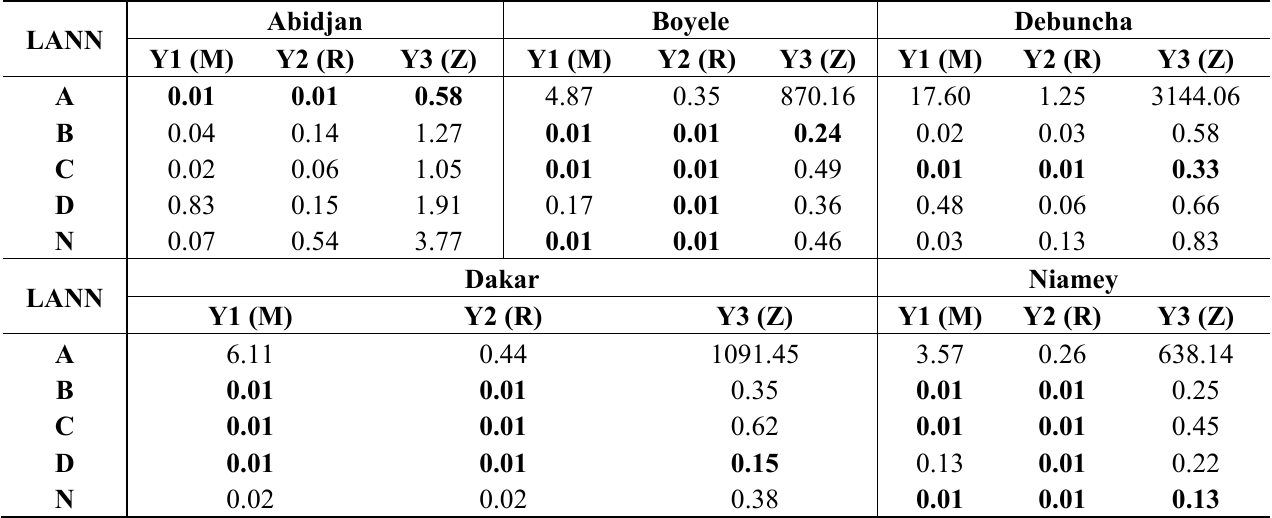
Table 4. Comparisons between RMSE after use of the different LANN (A, B, C, D and N). Abidjan Boyele Debuncha LANN